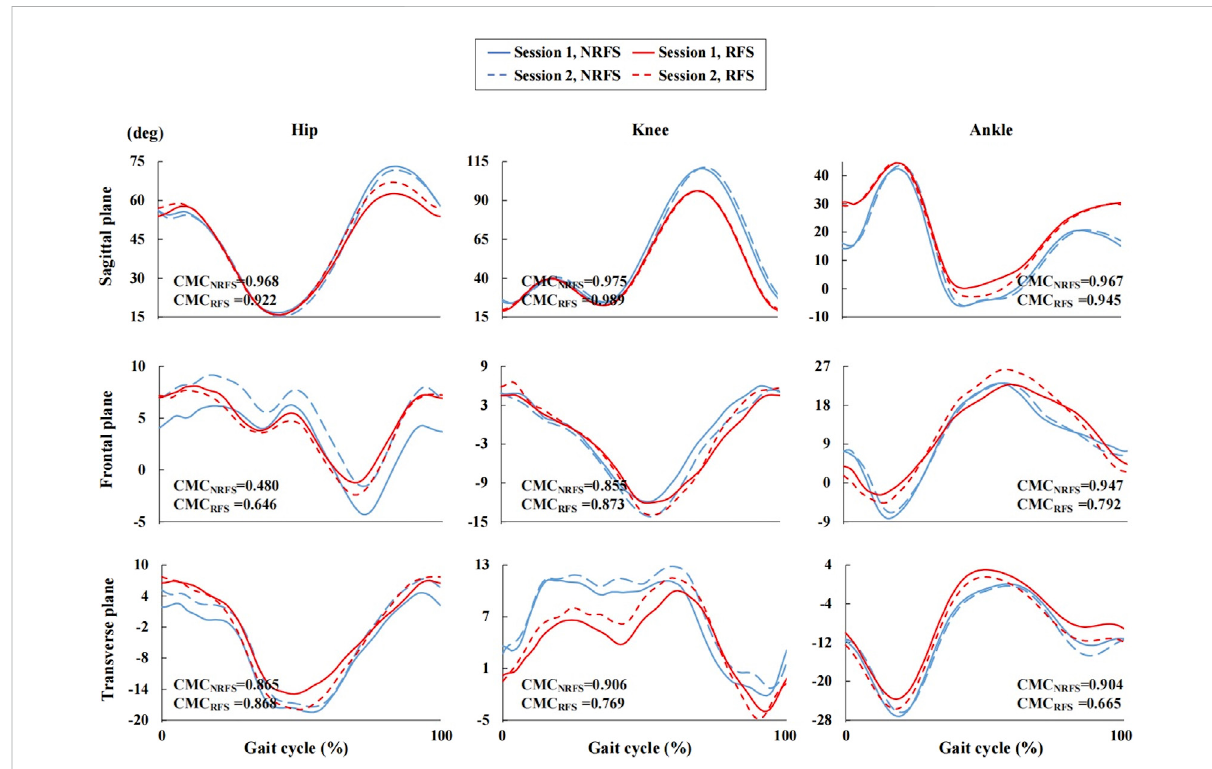
FIGURE 6 Joint angle waveforms during gait cycle measured by the inertial measurement units in session 1 and session